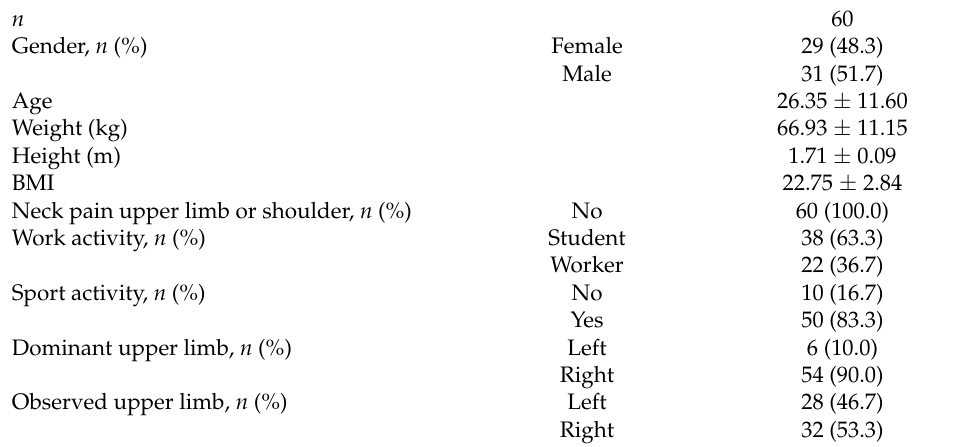
Table 1. Clinical and demographic characteristics of the participants.